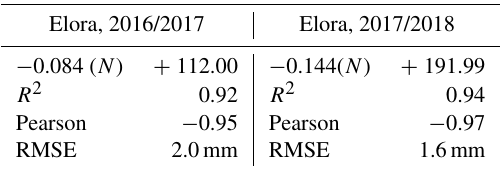
Figure 4. Snow survey SWE vs. CRNS-estimated SWE at Elora during both winter seasons. Outlier from 2017/2018 is outlined. Table 3. Statistical analysis summary of the Elora linear regres-